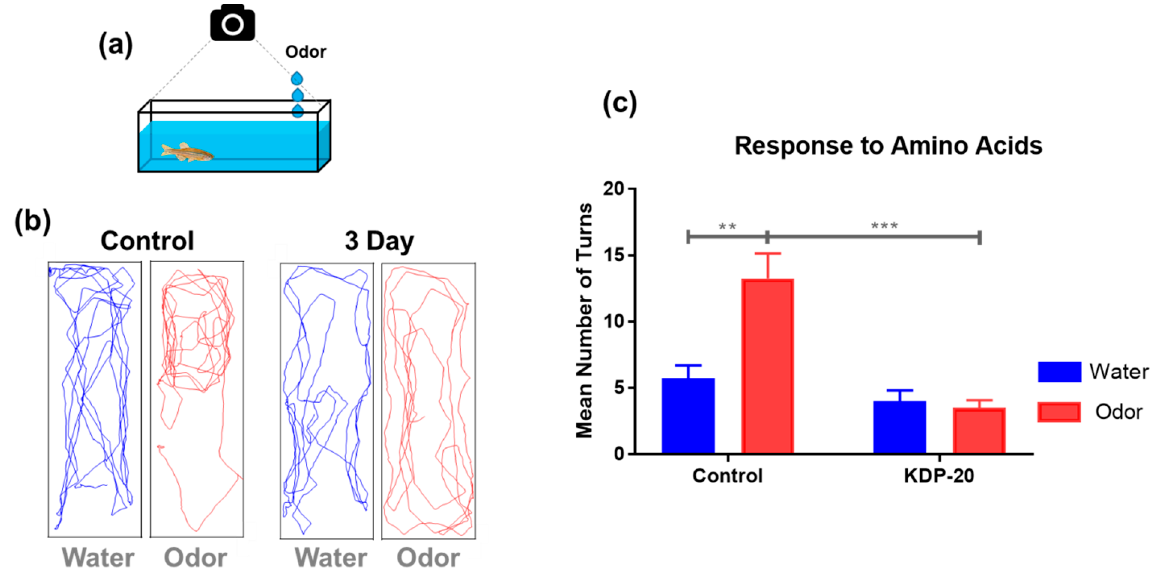
Figure 5. Odor-mediated behavior test of exposed zebrafish exposed to KDP20 for three days. ( a ) Scheme of odor-mediated behavior test. Odor is an amino acid mixture (alanine, cysteine, histidine, methionine, and valine; 10 mM each). The behavior of zebrafish was recorded aerially using a digital camera for 1 min per water and odor treatment. The recorded videos were analyzed using the animal tracker plug-in of Image J 1.52a software. ( b ) Behavior tracking image by water and odor treatment for one min. ( c ) Graph of mean number of turns in water and odor treatment for one min. Values are reported as mean ± SEM of five distinct olfactory samples. Statistical analysis by one-way ANOVA, ** p < 0.01, *** p < 0.001.